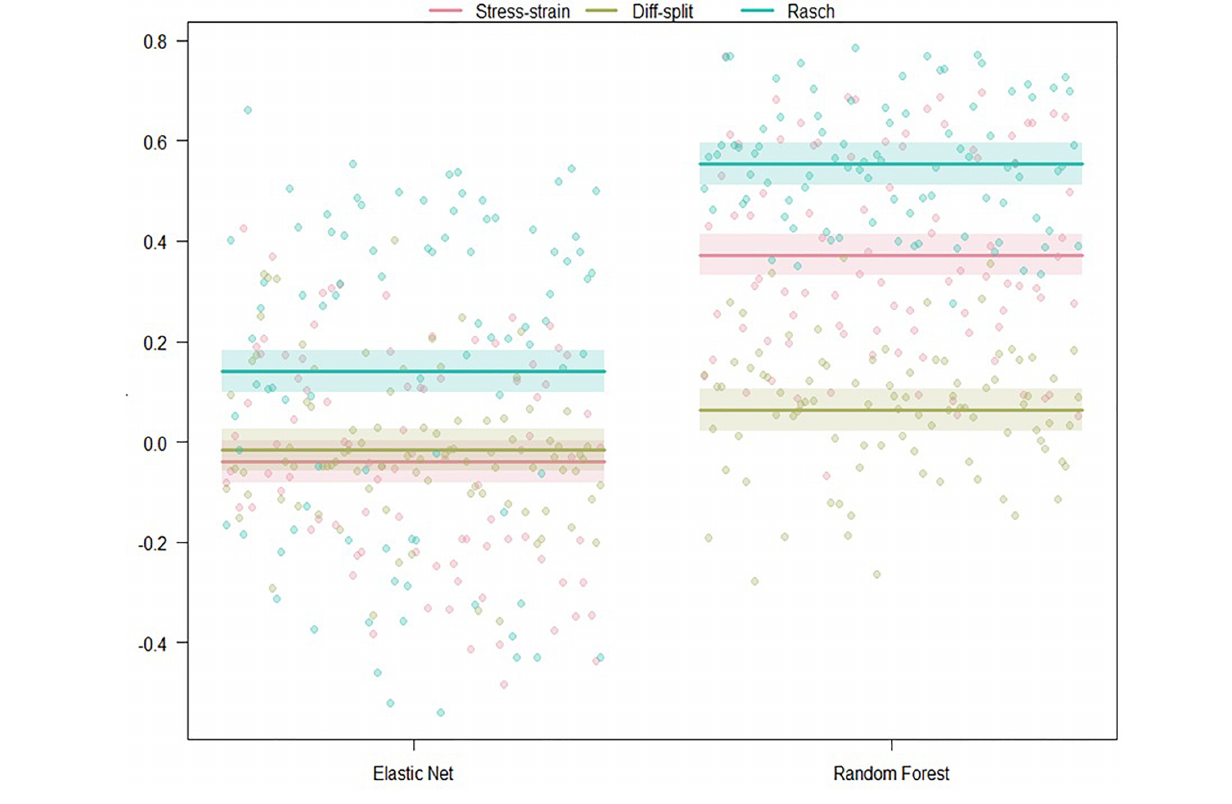
Frontiers in Human Neuroscience |